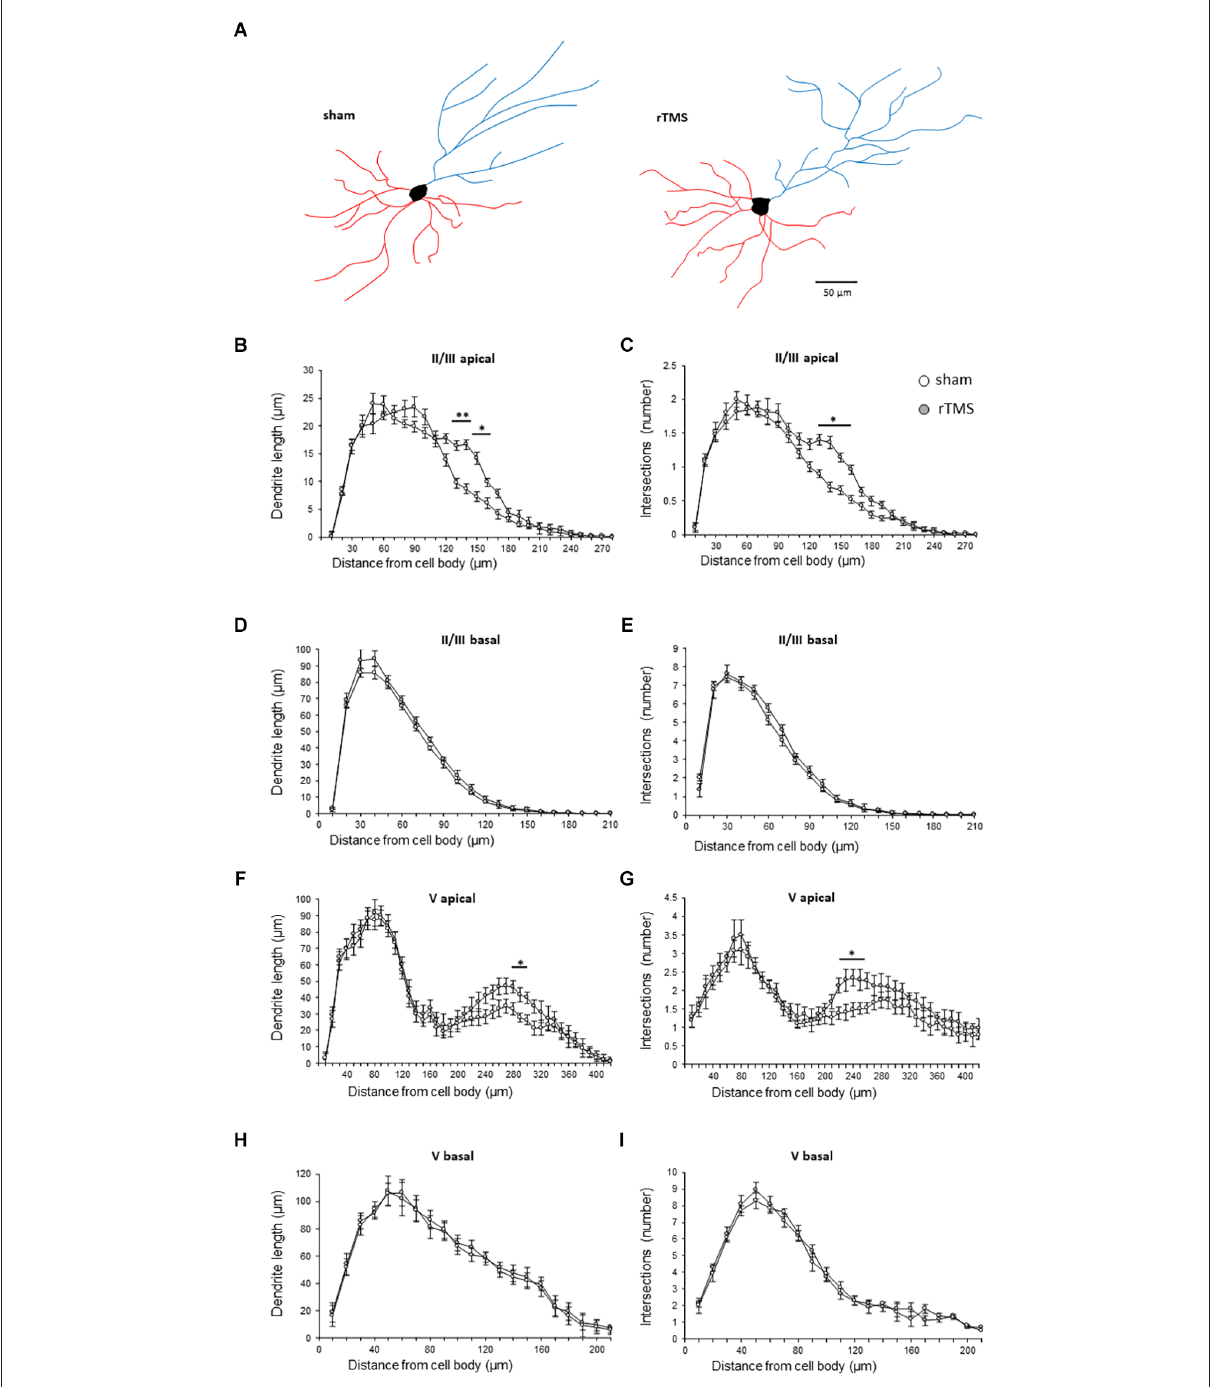
FIGURE4 HF-rTMS induced dendritic plasticity medial prefrontal cortex layer II/III and V pyramidal neurons apical dendrites. (A) Schematic representation of reconstructed layer II/III neurons for the sham and HF-rTMS groups (scale bar = 50 mm). Quantification of dendritic length and the number of intersections in both layer II/III pyramidal neurons apical (B,C) and basal (D,E) dendrites and in layer V pyramidal neurons apical (F,G) and basal (H,I) dendrites. Means ± SE. ∗ p < 0.05, ∗∗ p < 0.01.